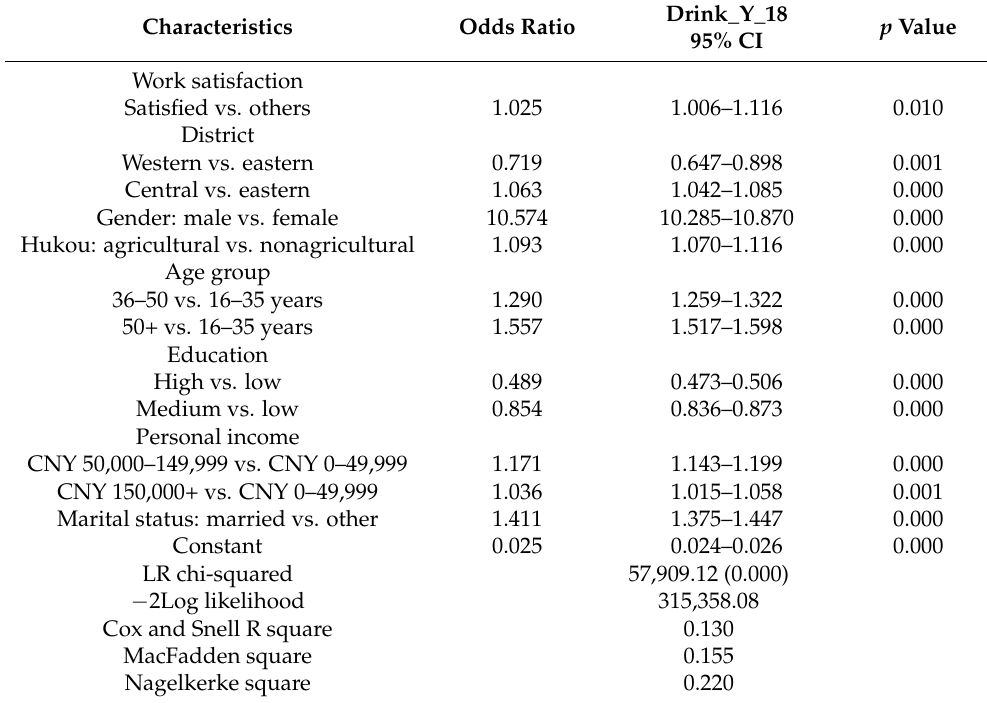
Table 2. Multivariable logistic regression